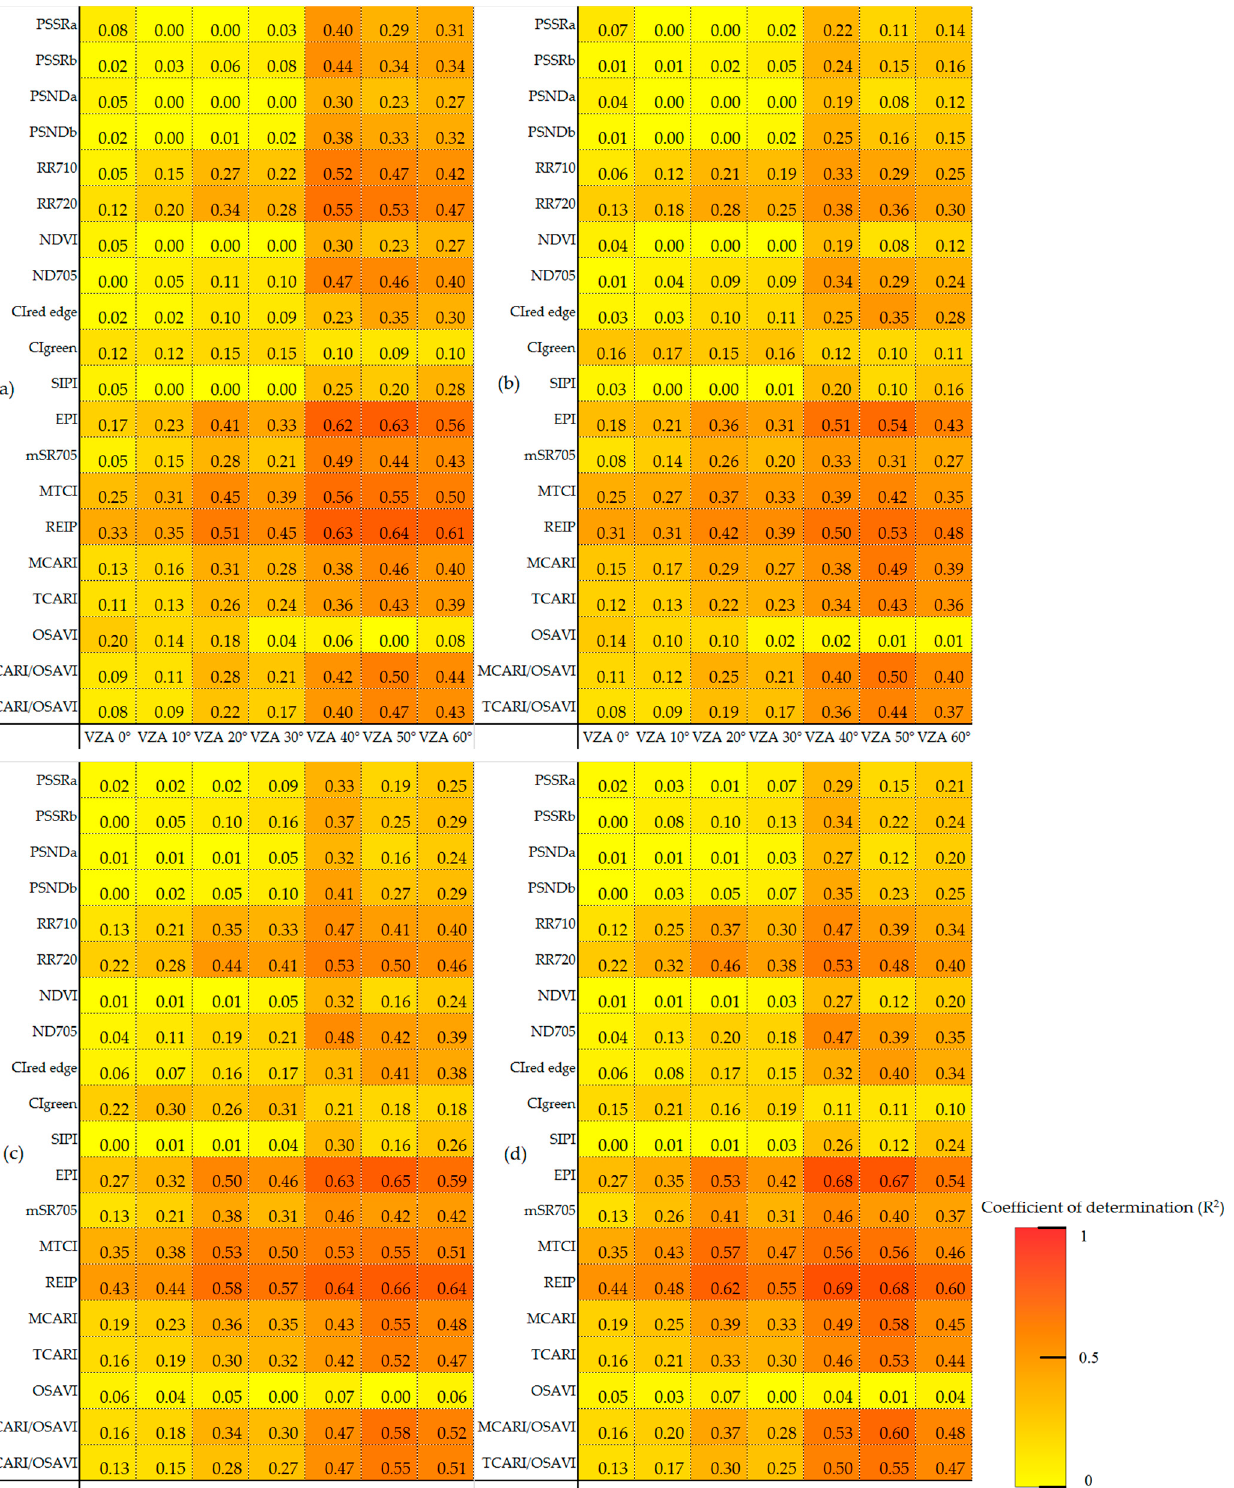
Figure 4. Coefficients of determination between the SPAD value in the late growth stage and the chlorophyll sensitivity index of different VZAs: ( a ) 1st layer, ( b ) 2nd layer, ( c ) 3rd layer, and ( d ) 4th layer.